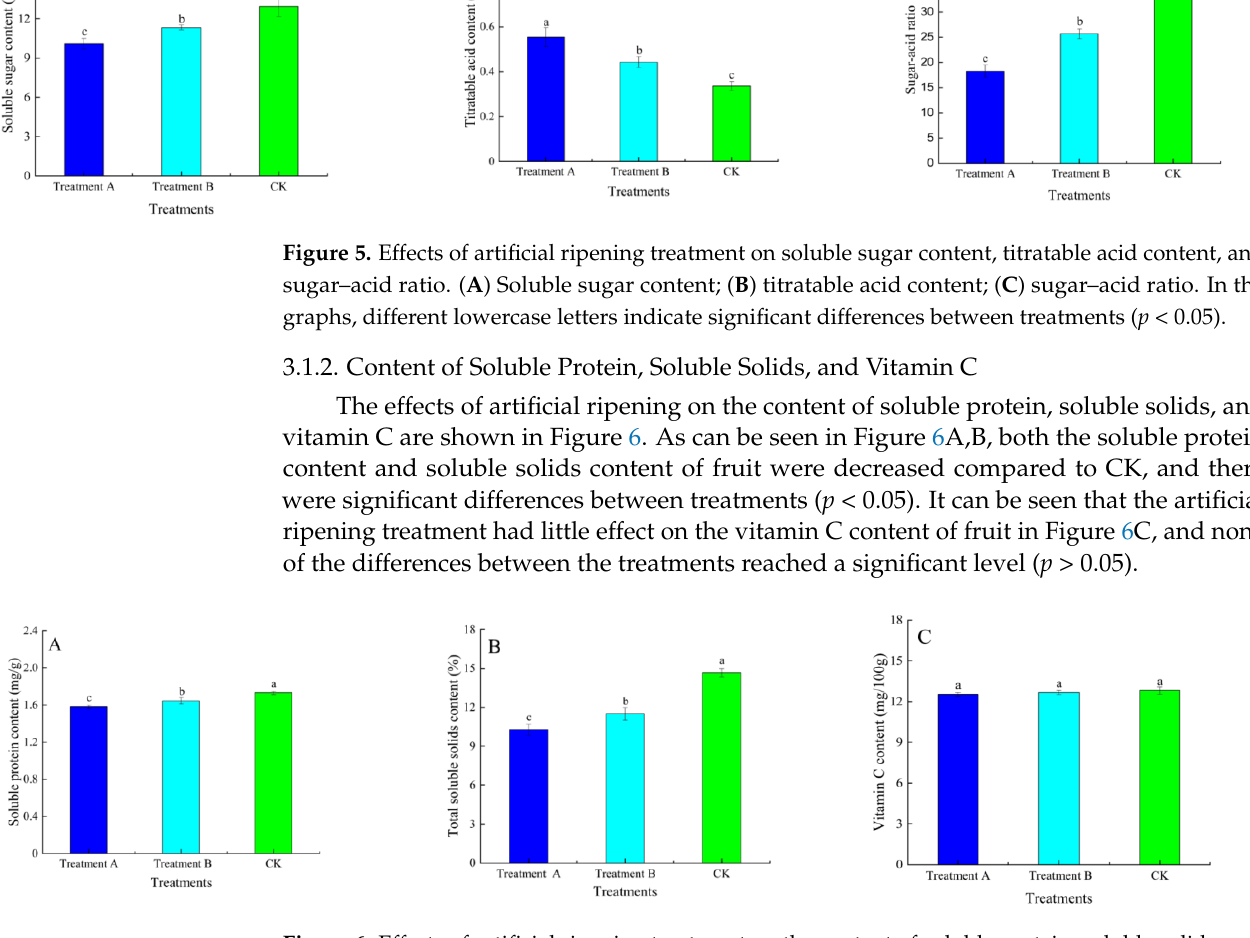
Figure 6. Effects of artificial ripening treatment on the content of soluble protein, soluble solids, and vitamin C. ( A ) soluble protein content; ( B ) soluble solids content; ( C ) vitamin C content. In the graphs, different lowercase letters indicate significant differences between treatments ( p < 0.05).